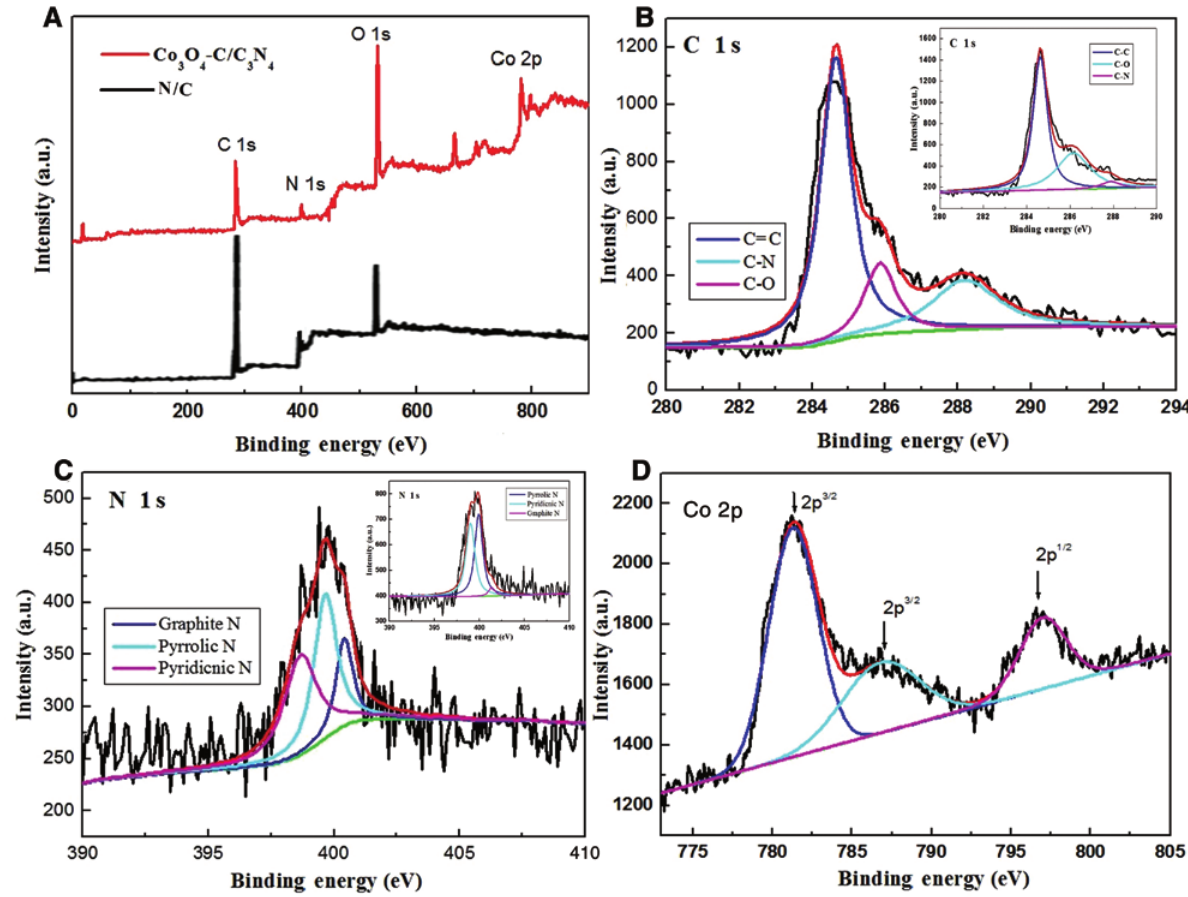
O -C/C N and C/N, (B) high resolution of C 1s, (C) N 1s, and (D) Co 2p 3 4 3 4